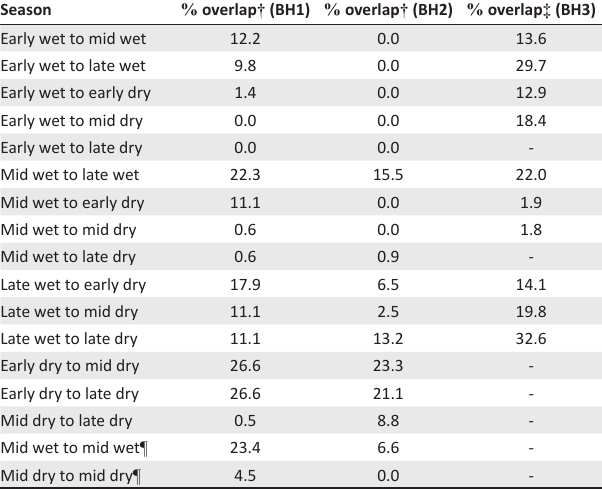
TABLE 1: Percentage overlaps of home ranges by buffalo in different seasons over the 2012 and 2013. Season